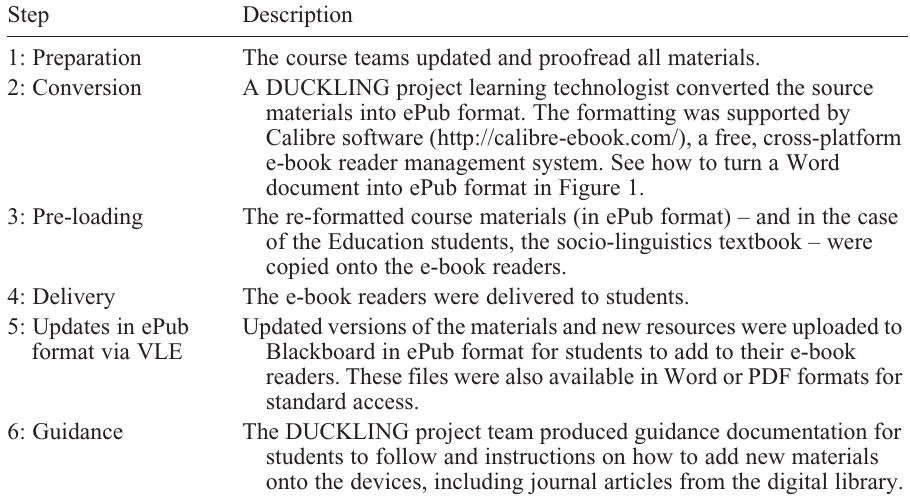
Table 1. Making course materials available on the e-book